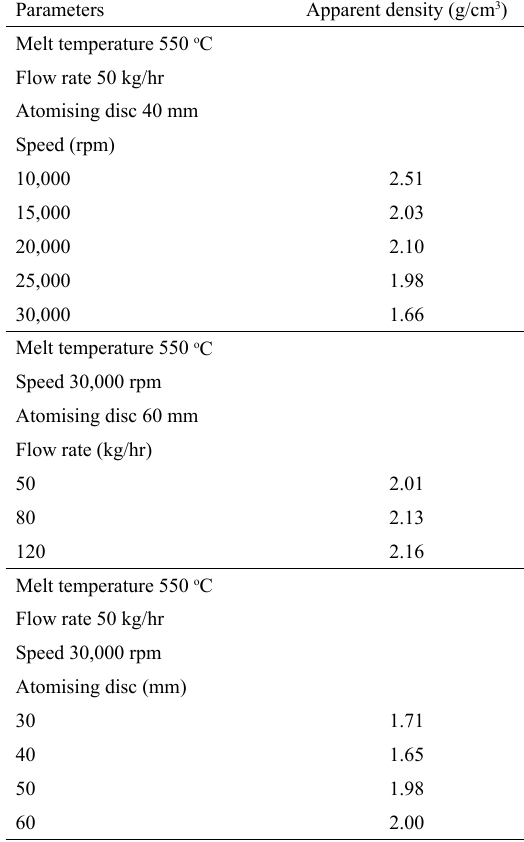
Table 3. Apparent densities of zinc powders, determined by Carney funnel Parameters